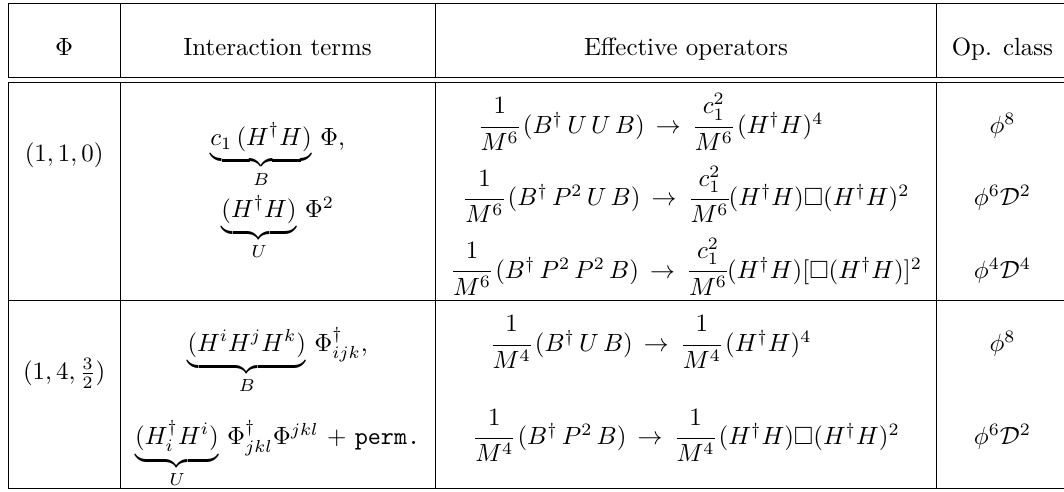
quadruplet Φ ∈ (1 , 4 , 3 ) . Here, L 2